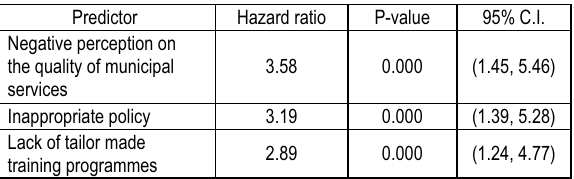
Table 3. Hazard ratios obtained from Cox regression